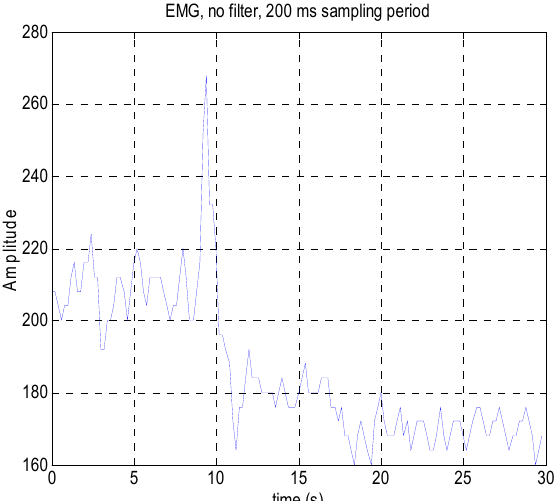
Figure 15. EMG measurement: a moderate muscle contraction is followed by a strong and a loose one. 200 ms sampling period is used with no filtering.